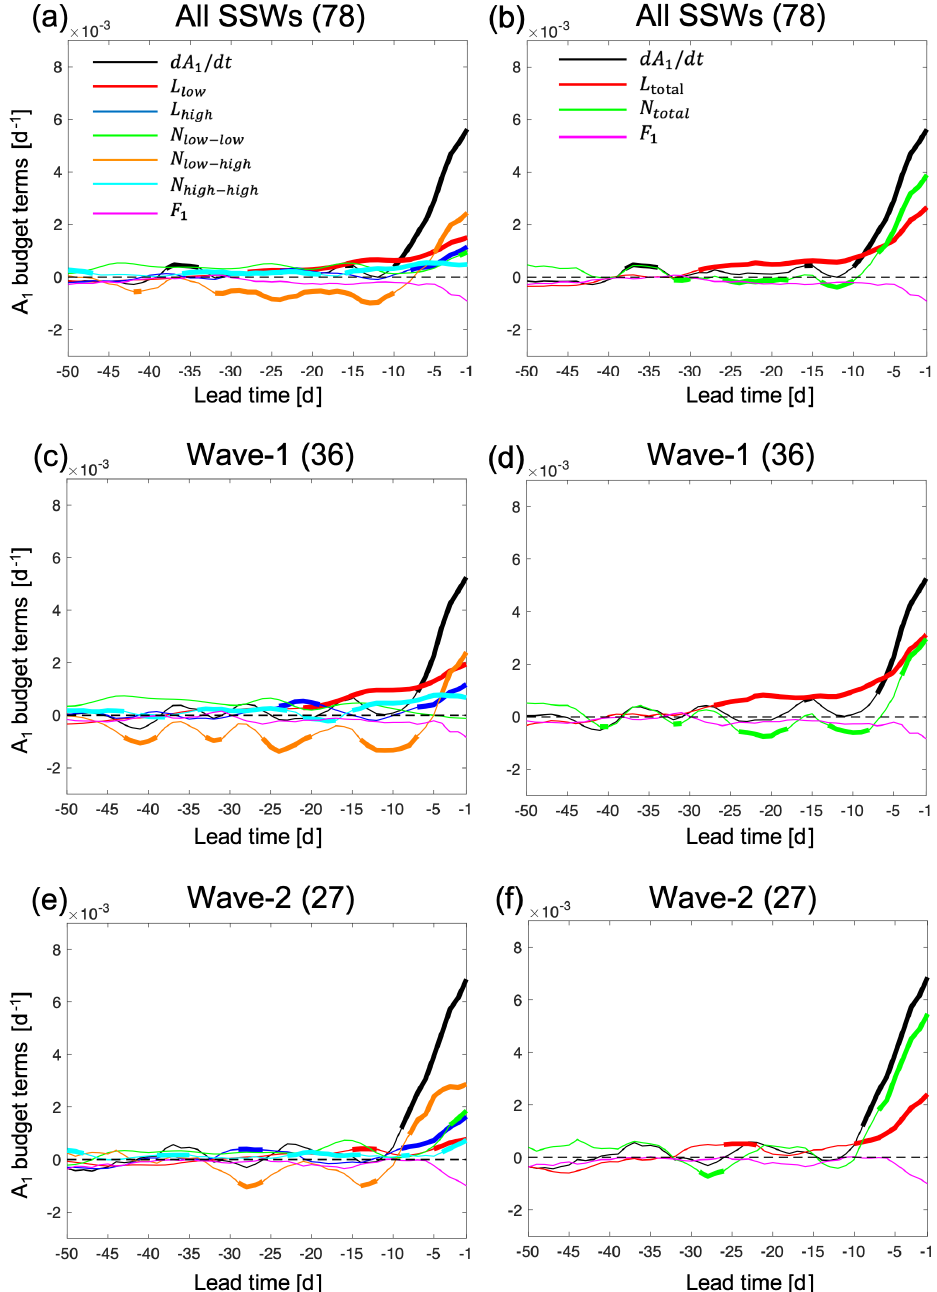
Figure 5. The composite of A 1 budget as a function of lead time from 50 to 1d before the onset of the events in the Isca model output. (a, b) Composite of the total 78 SSW events, (c, d) composite of the 37 wave-1 events, and (e, f) composite of the 26 wave-2 events. (a, c, e) show each term of Eq. (5) separately, and (b, d, f) show the total linear term and the total nonlinear term for the different subsets of SSWs. All lines are smoothed by a 5d running mean. Bold lines indicate the values that are outside the percentile range 2.5 to 97.5 of normal winter day values from bootstrapping as described in the text. The representation of each line color in (c, e) and (d, f) is the same as the legend in (a) and (b) ,